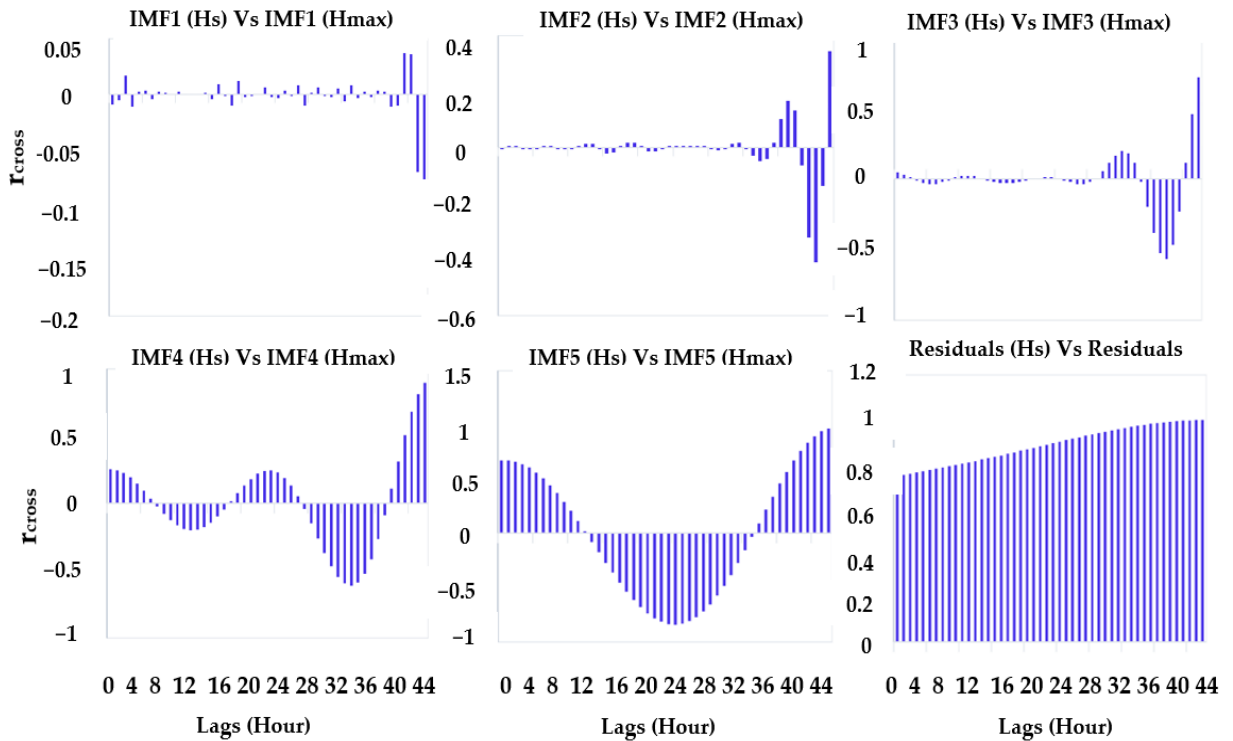
Figure 4. Correlogram showing the covariance between the objective variable (Hs) in terms of the cross-correlation coefficient (rcross) for Cairns.